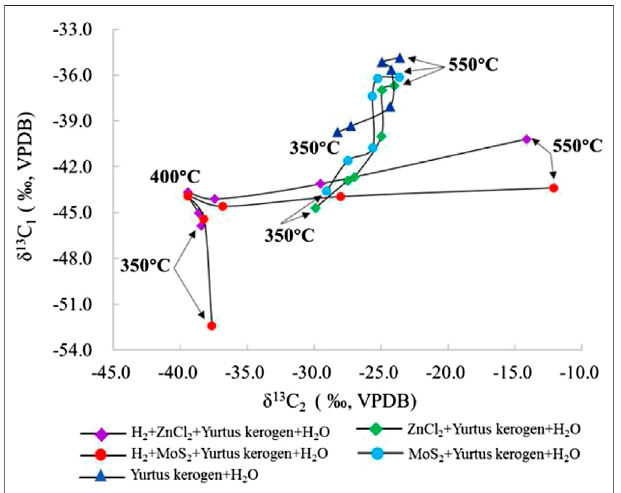
FIGURE 12 | Change in the δ 13 C values of different alkanes and CO 2 under the simulated MoS 2 catalyzed hydrogenation control condition of the closed